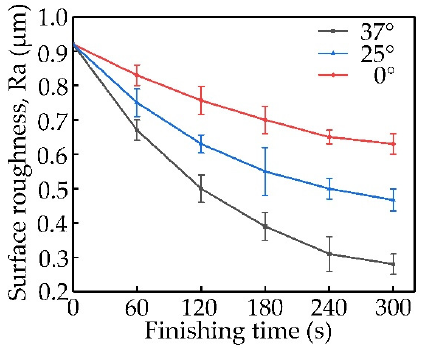
Figure 5. The impact of the shape of the magnetic head on surface roughness.